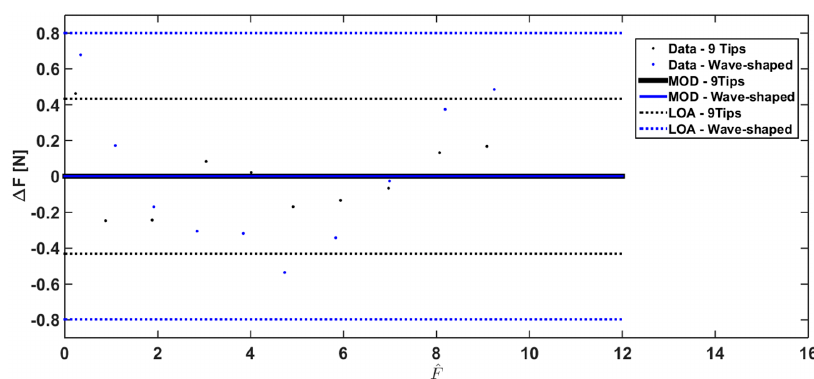
Figure 12. Bland Altman analysis comparing F c with F r for the two loading conditions under human-like grasping conditions (results obtained with the 9 Tips load and with the Wave-shaped load are shown in black and in blue, respectively).